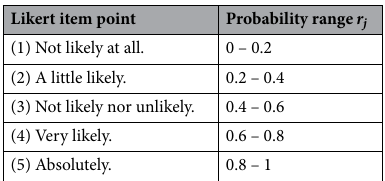
Table 1. Conversion of discrete vaccine willingness Likert score to continuous probability of getting